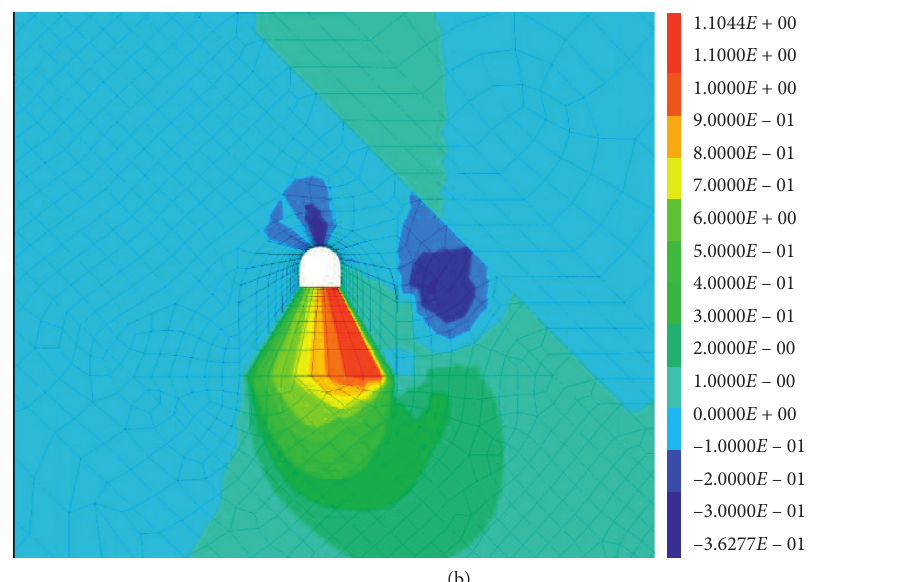
Figure 4: Nephogram of vertical displacement of surrounding rock of roadway: (a) without support; (b) original